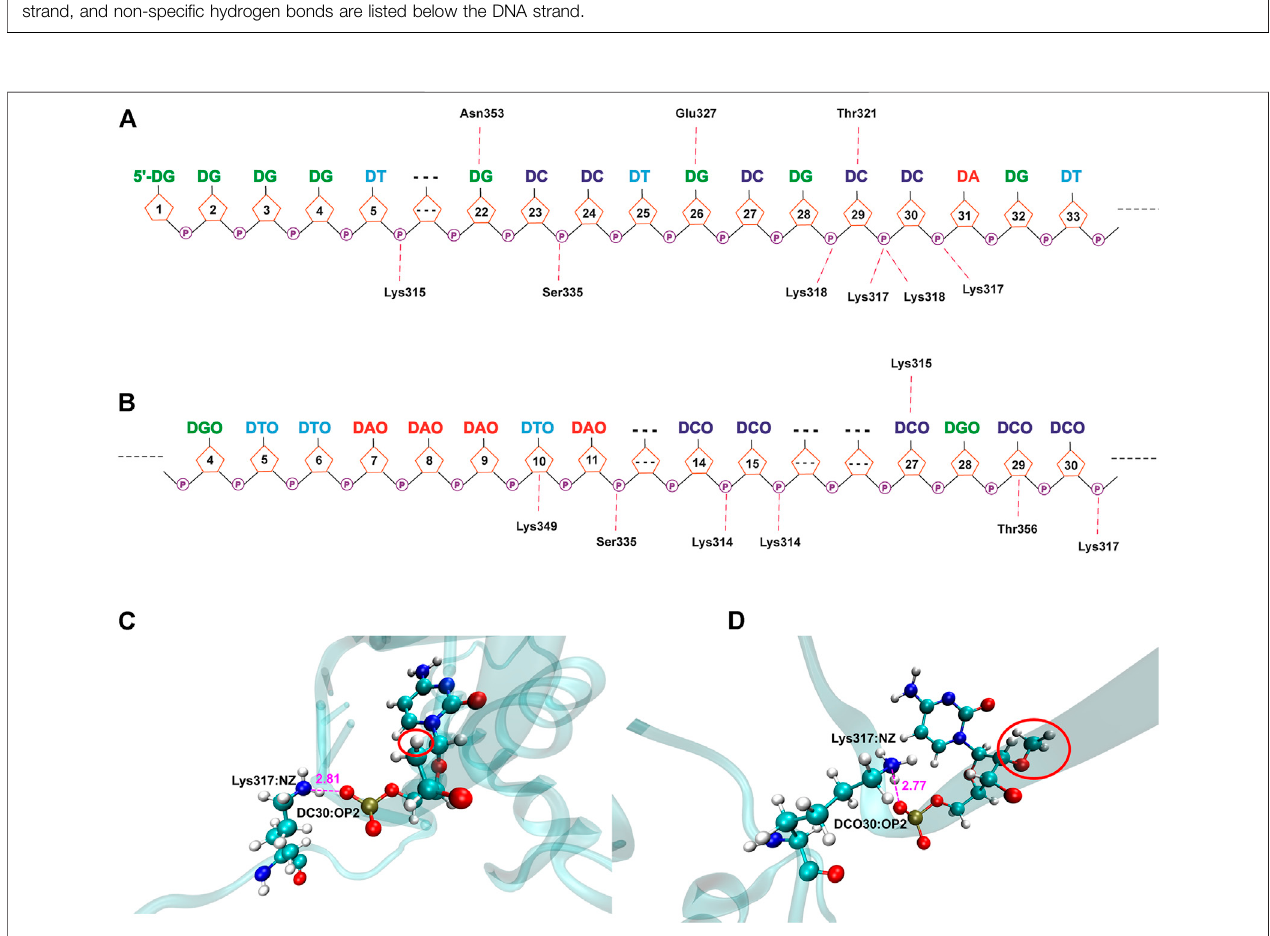
FIGURE 9 | Hydrogen bond networks for protein – DNA complexes. (A) DEK_C/DTA. (B) DEK_C/DTA_OMe. Speci fi c hydrogen bonds are listed above the DNA strand, and non-speci fi c hydrogen bonds are listed below the DNA strand. (C,D) The detailed hydrogen bond interaction diagram between DCO30 and Lys317 in DEK_C/DTA and DEK_C/DTA_OMe complexes.